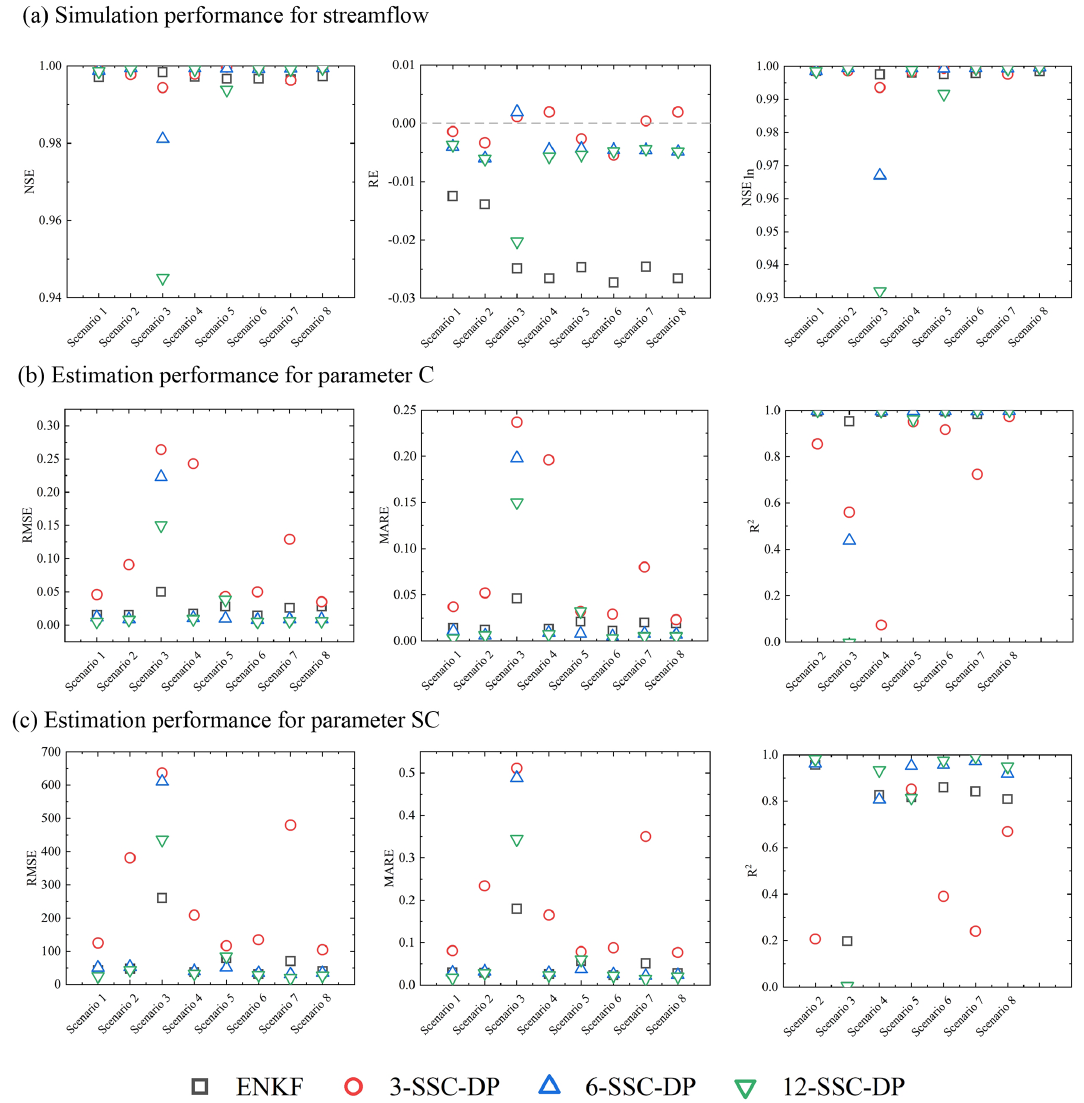
Figure 6. Comparison between the EnKF and SSC-DP methods for (a) streamflow simulation and identification of (b) parameter C and (c) parameter